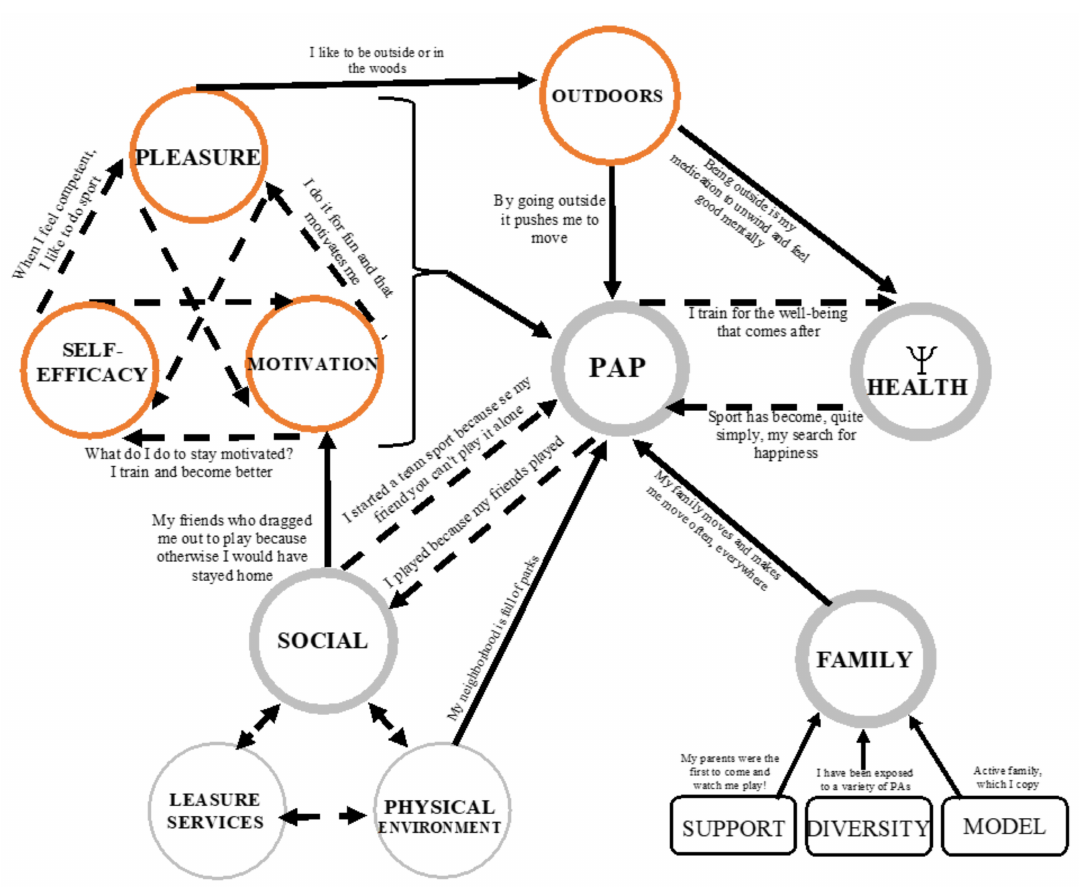
Figure 3. Role of enjoyment, self-efficacy, motivation and the outdoors in the adoption and maintenance of healthy lifestyle